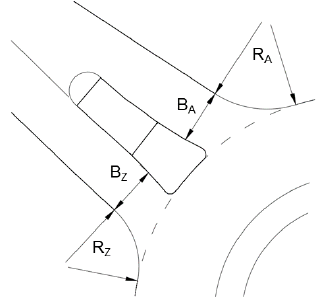
Figure 24. Design elements of roundabout entry and exit according to [9].